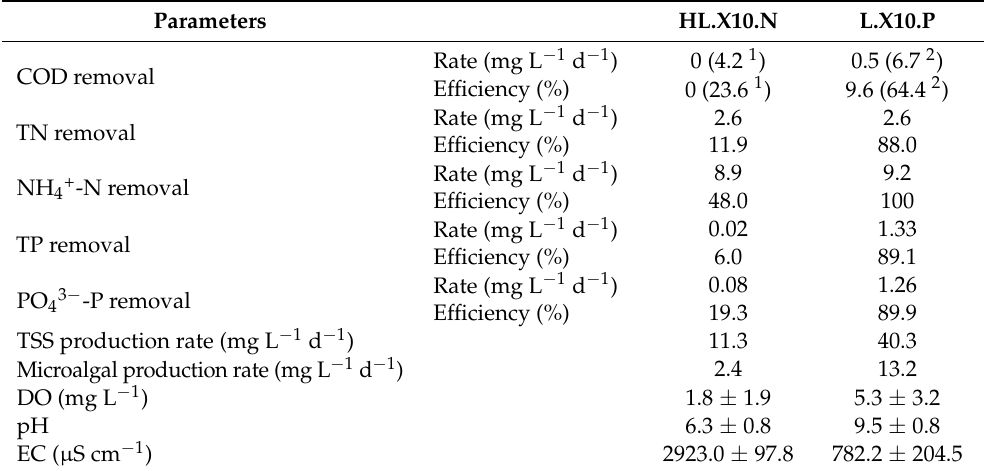
Table 5. Microalgal bacterial performance including average removal rate, removal efficiency, biomass production rate and physicochemical parameters (with standard deviations) under the impacts of extreme N:P ratios.